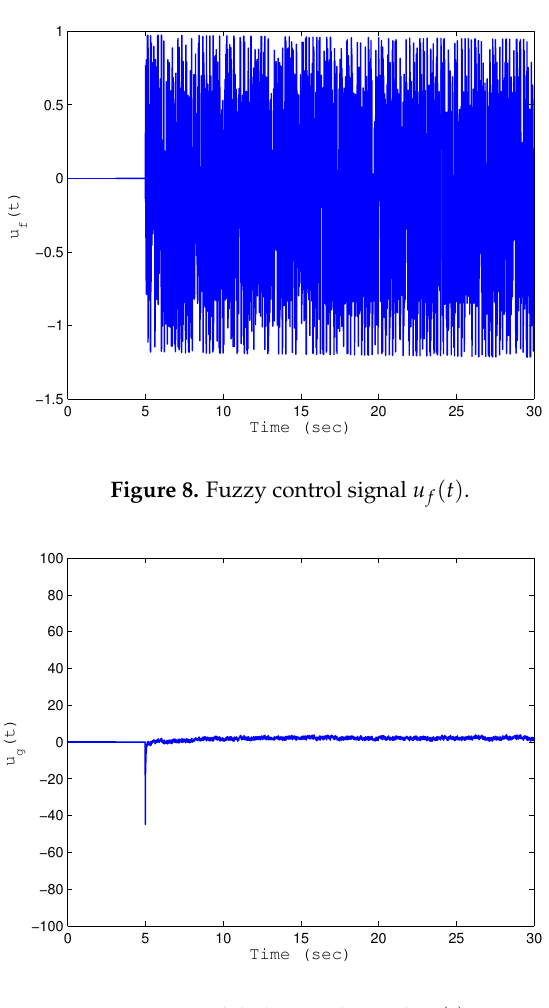
Figure 9. Global control signal u g ( t )